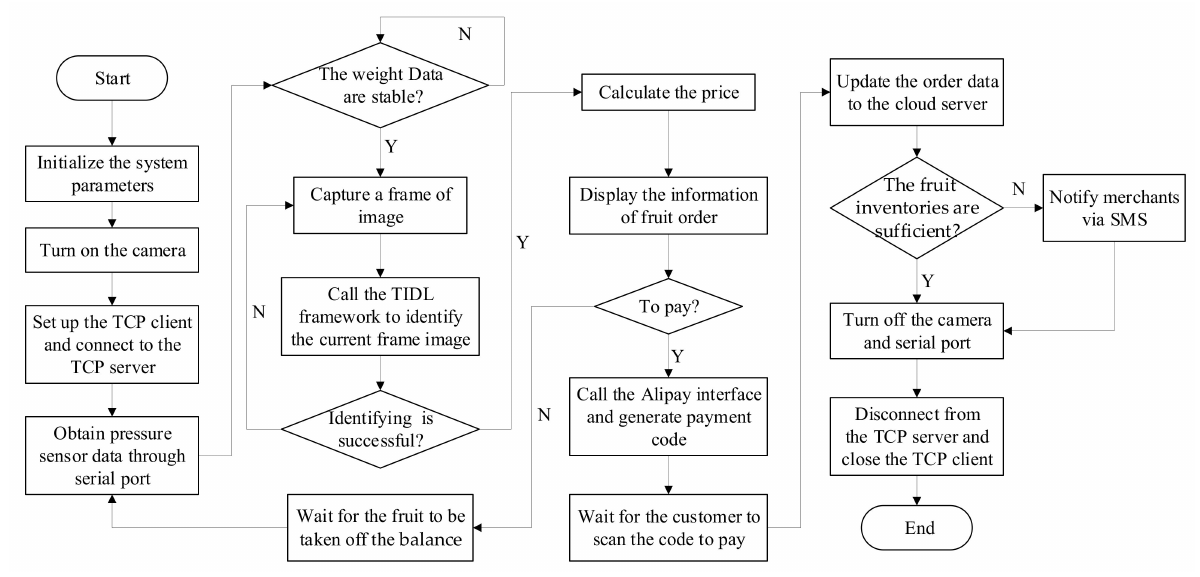
Figure 2. The flow chart of the main control